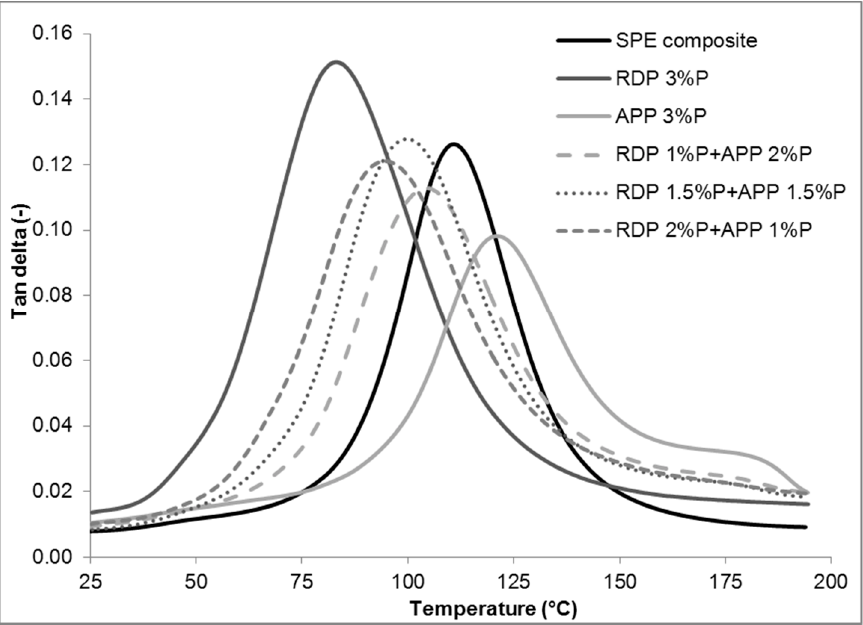
Figure 5. Tan delta curves of reference and 3% P-containing SPE composites. Table 3. Effect of the additive flame retardants on the glass transition temperature (T g ) of SPE composites. Flame Retardant Composition tan delta [-] T g [ ◦ C] SPE composite reference